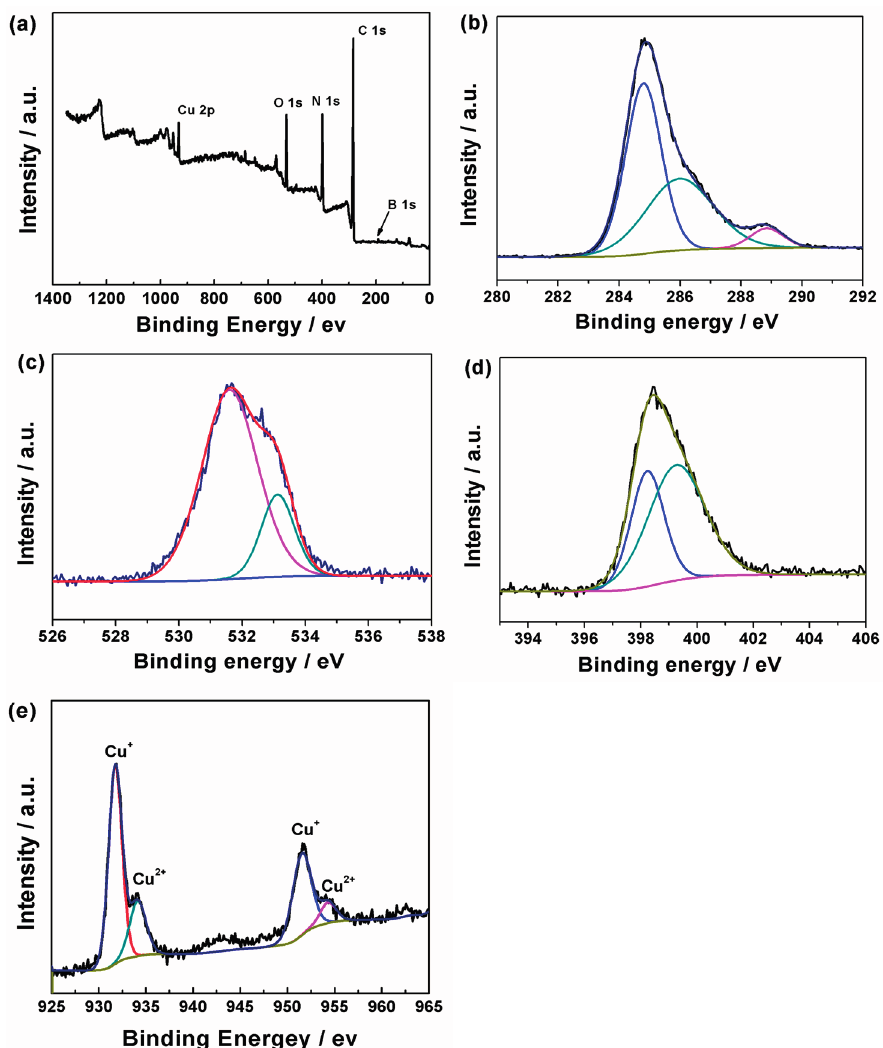
Figure 3. XPS spectra of Cu-CNB: ( a ) Cu-CNB; ( b ) C 1s; ( c ) O 1s; ( d ) N 1s; and ( e ) Cu 2p.